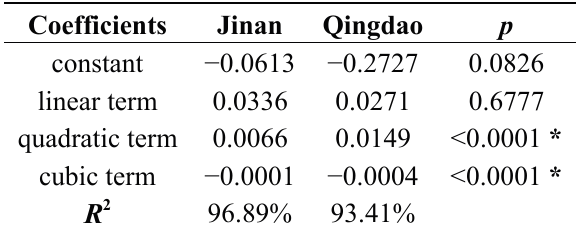
Table 2. The location-specific association pattern between temperature and HFMD